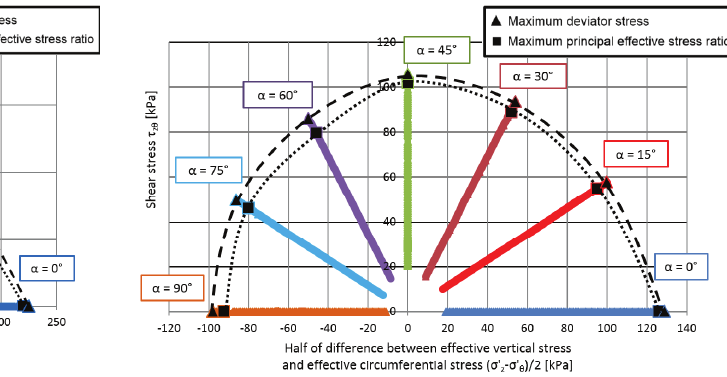
Fig. 1. Effective stress paths for clay in axes Fig. 2. Effective stress paths for sandy silty clay in axes